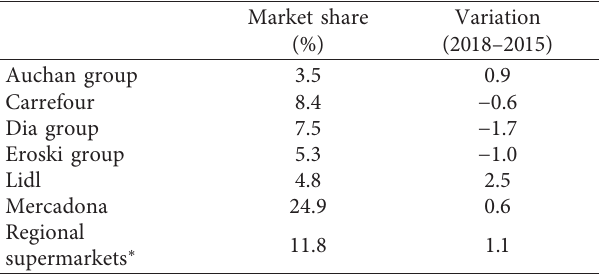
Figure 4: Triangulation of inverse matrix 2017. Source: own compilation. Table 13: Market share of supermarket chains in Spain